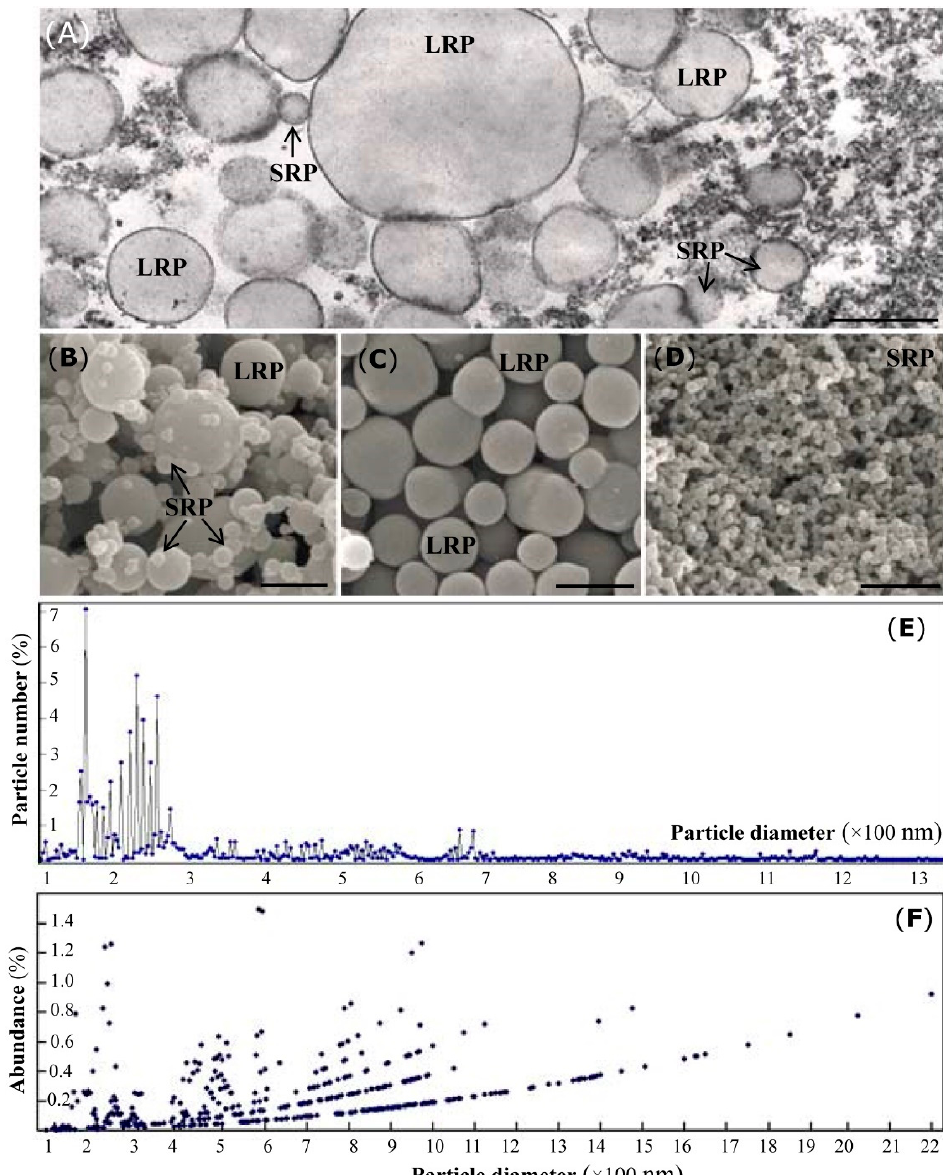
Figure 1. Morphological patterns of the Para rubber particles. Typical ultrastructural patterns of large rubber particles (LRPs) and small rubber particles (SRPs) were examined under TEM ( A ) and SEM ( B – D ), respectively. Under TEM, many spherical and pear-like LRPs were observed (A). Under SEM, more SRPs were detected in the total rubber particles (TRPs) collected from the fresh rubber latex ( B ). After separation, no SRPs were detected from the purified LRPs ( C ), and vice versa ( D ). The percent number ( E ) and abundances ( F ) of different rubber particles are highlighted. Bar, 1.0 μ m.